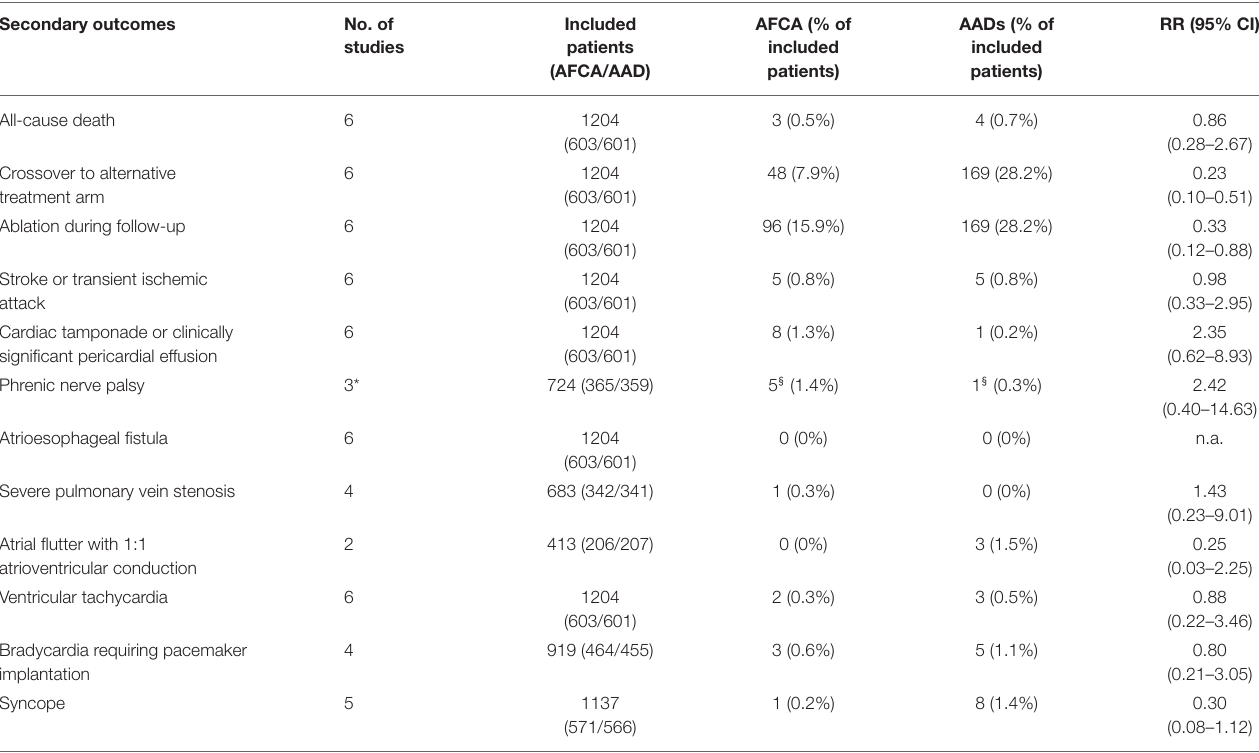
TABLE 3 | Meta-analysis results for pre-specified secondary